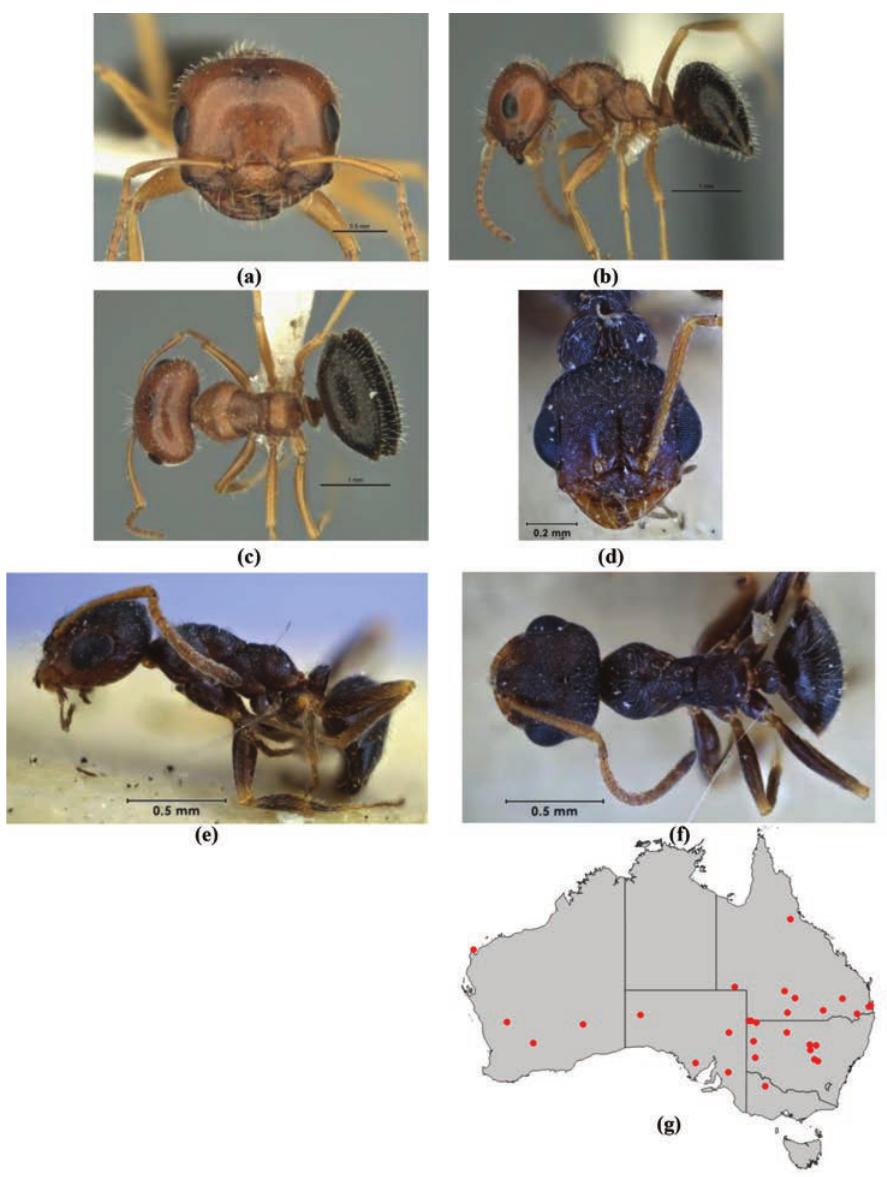
Figure 53. Melophorus bruneus McAreavey: non–type major worker (ANIC32-900218) frons ( a ), profile ( b ) and dorsum ( c ); minor worker paratype (ANIC32-053433–top card) frons ( d ), profile ( e ) and dor- sum ( f ); distribution map for the species ( g ). Low resolution scale bars: 1 mm ( b, c ); 0.5 mm ( a